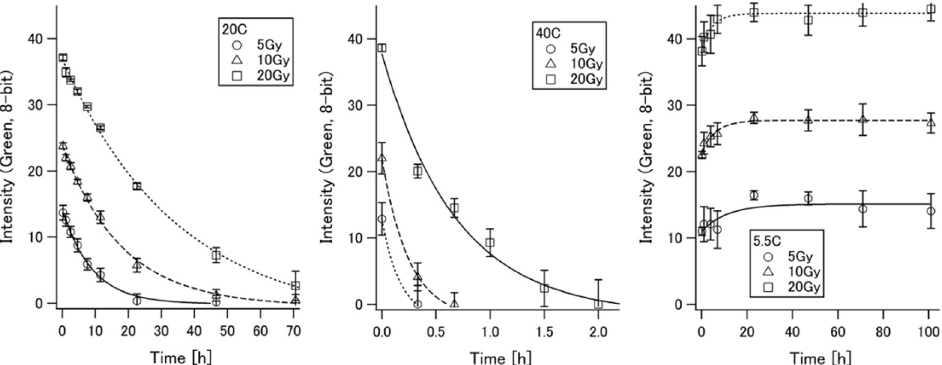
Figure 5. Time changes of the green component of PAISiN after irradiation of 5 Gy, 10 Gy or 20 Gy γ -rays under different temperatures: 20 °C ( left ), 40 °C ( middle ) and 5.5 °C ( right ).